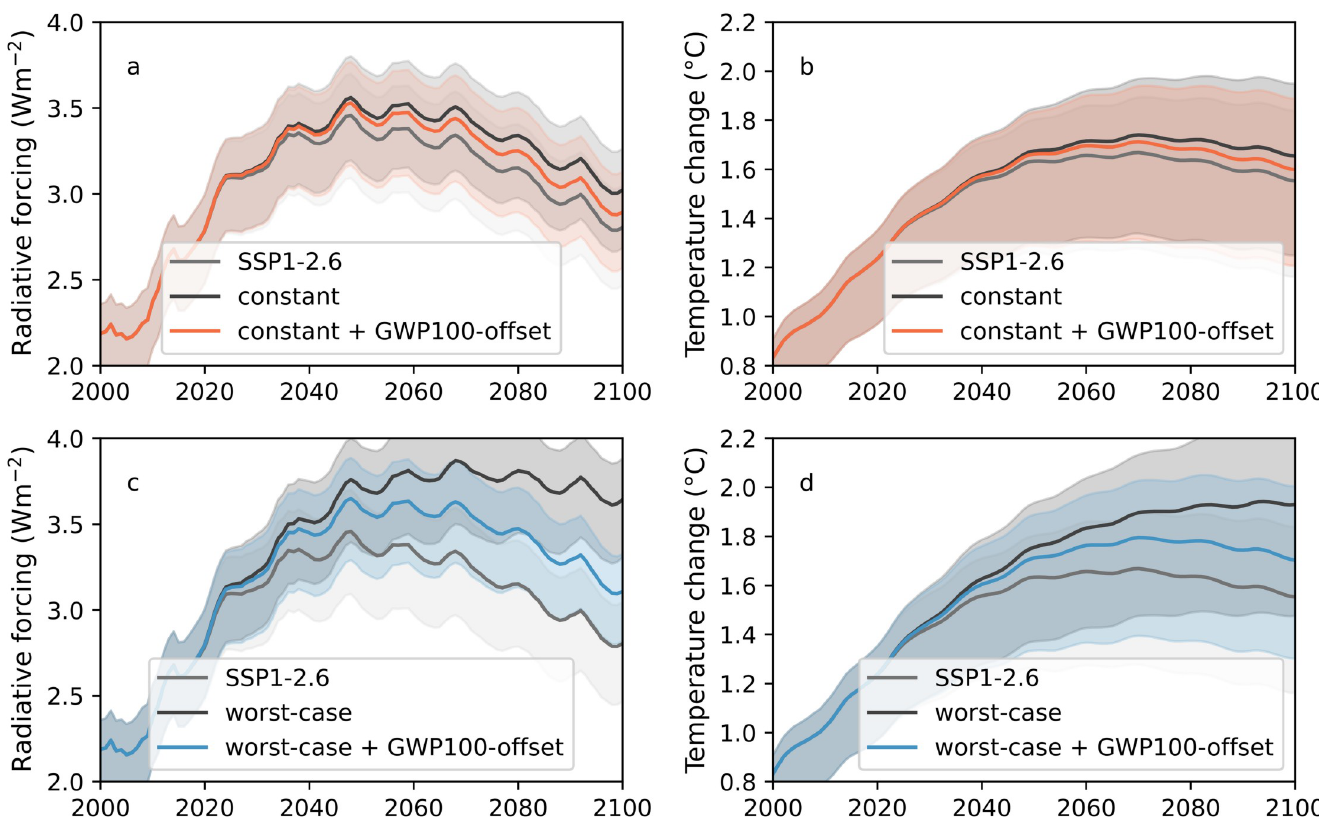
Fig 3. Radiative forcing and temperature anomaly under GWP100 offsetting compared to reference scenarios. Effective radiative forcing (ERF) and temperature anomaly relative to the 1850–1900 average under the SSP1-2.6 scenario (SSP1-2.6), under the alternative emission scenario (constant or worst-case scenario), and under the offsetting scheme using the GWP100 metric. ERF and temperature anomalies result from all forcing agents taken into account by the FaIR model, including natural forcing from solar variability that causes the decadal scale cycle in ERF and temperature anomaly [64, 65]. Thick lines represent simulations with best-estimate parameters [65] whereas shaded areas encompass the 95%-interval of the ensemble simulations. a) ERF under the constant agricultural emission scenario. b) Change in temperature under the constant agricultural emission scenario. c) ERF under the worst-case agricultural emission scenario. d) Change in temperature under the worst-case agricultural emission